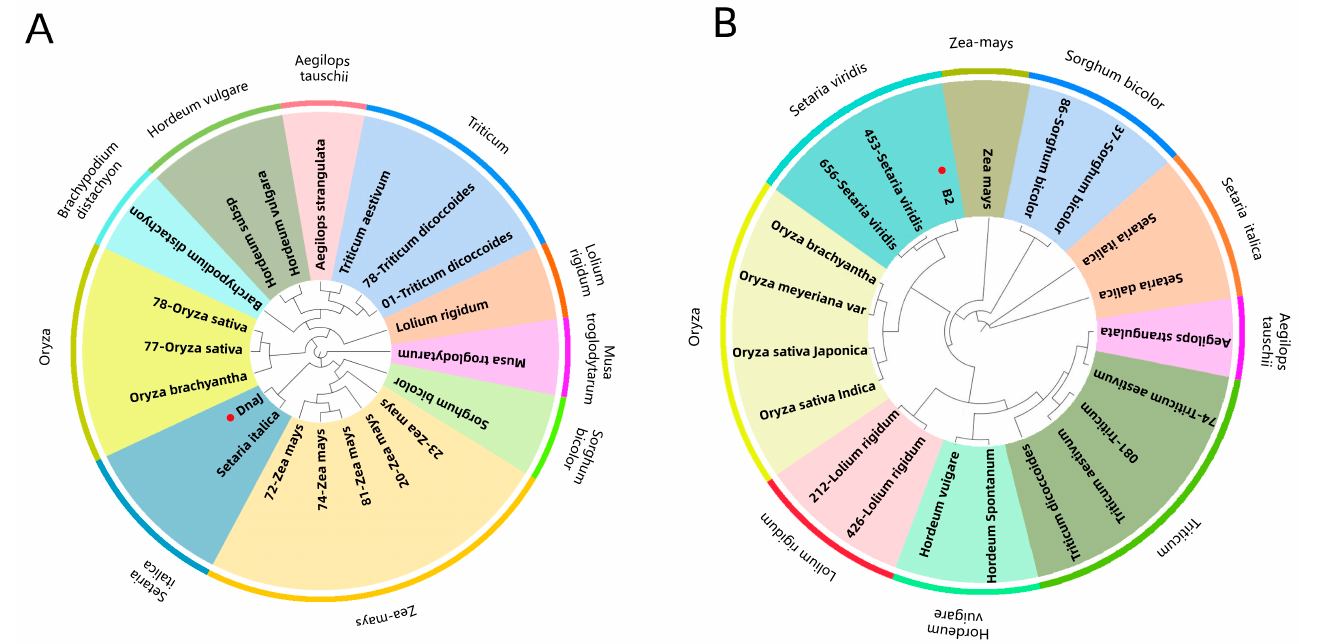
Figure 6. Phylogenetic trees of B2 and DnaJ proteins. Note: ( A ): the phylogenetic tree of the relationship between the DnaJ protein and Gramineae was constructed using the adjacency method (NJ). The different color plates on the circle represent different genera of Gramineae, and the solid red dots represent the DnaJ protein in hybrid bamboo. ( B ): The phylogenetic tree of the relationship between the B2 protein and Gramineae was constructed using the adjacency method (NJ). The different color plates on the circle represent different genera of Gramineae, and the solid red dots represent the B2 protein in hybrid bamboo. Because the whole genome sequence of B. pervariabilis × D. grandis is not yet available, the interacting proteins can only be mapped to other species.